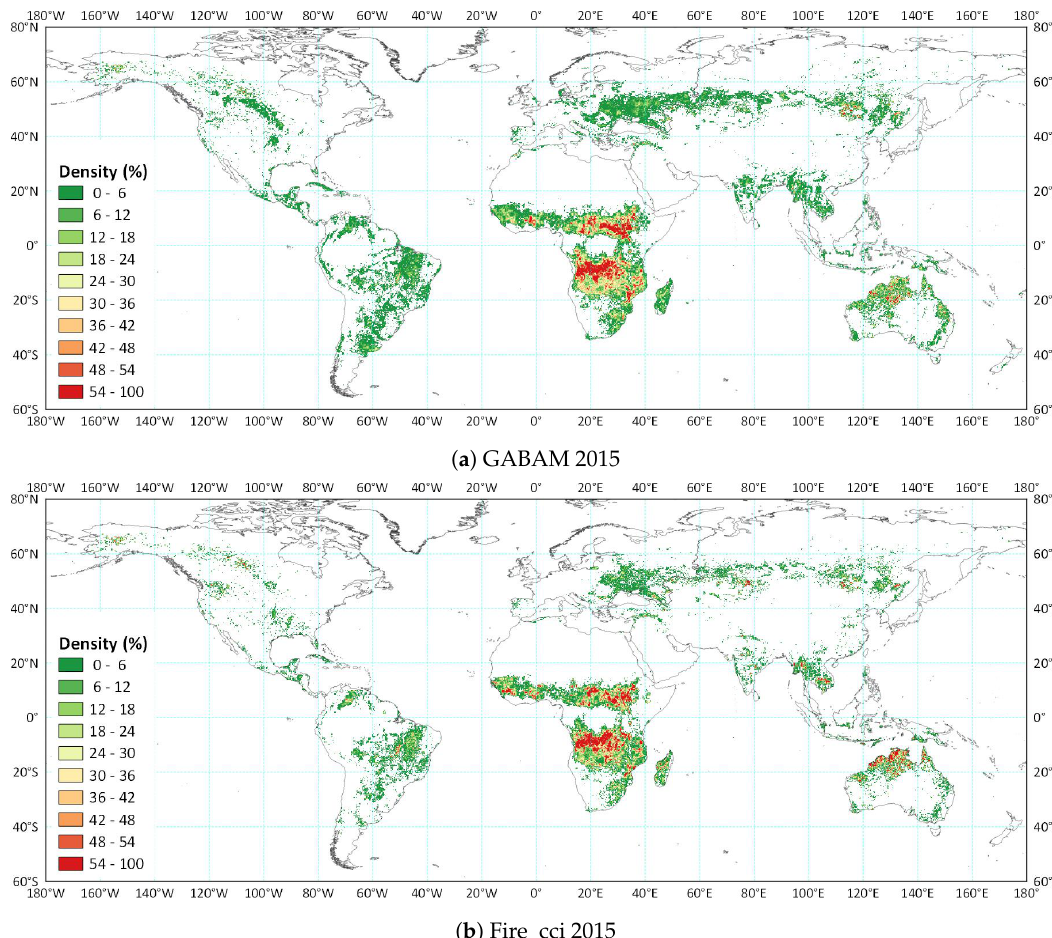
Figure 8. Global distribution of burned area density (percentage of burned pixels in every 0.25 ◦ × 0.25 ◦ grid) of GABAM and Fire_cci product within 2015. ( a ) is the annual grid composition of BA of GABAM, and ( b ) is that of the Fire_cci